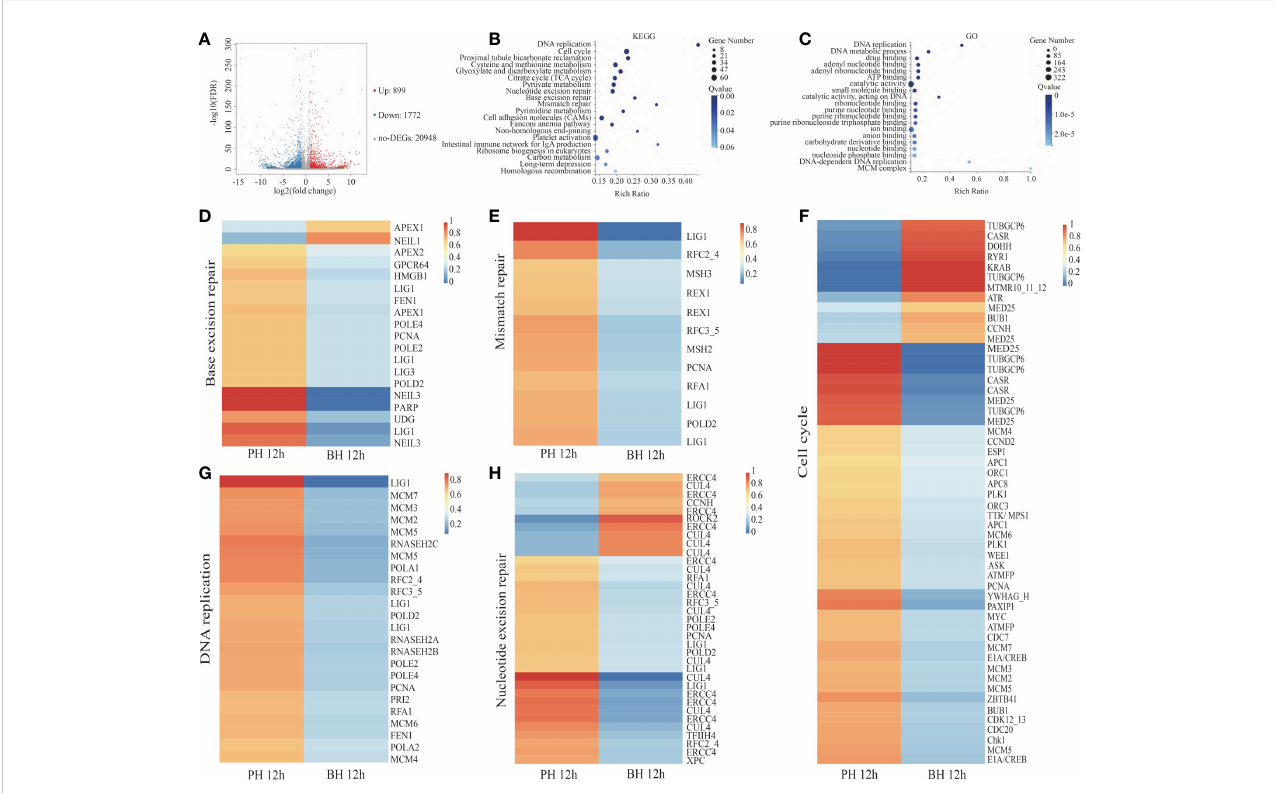
FIGURE 3 Analysis of DEGs between PH and BH group after transplantation 12 (h) (A) . Volcano map of DEGs between PH and BH groups after transplantation 12 (h) Impacted pathway (B) and GO (C) of butyrate on the genes regulated by transplantation. Expression of the related genes in the Base excision repair (D) , Mismatch repair (E) , Cell cycle (F) , DNA replication (G) , Nucleotide excision repair (H) in PH and BH groups after transplantation 12